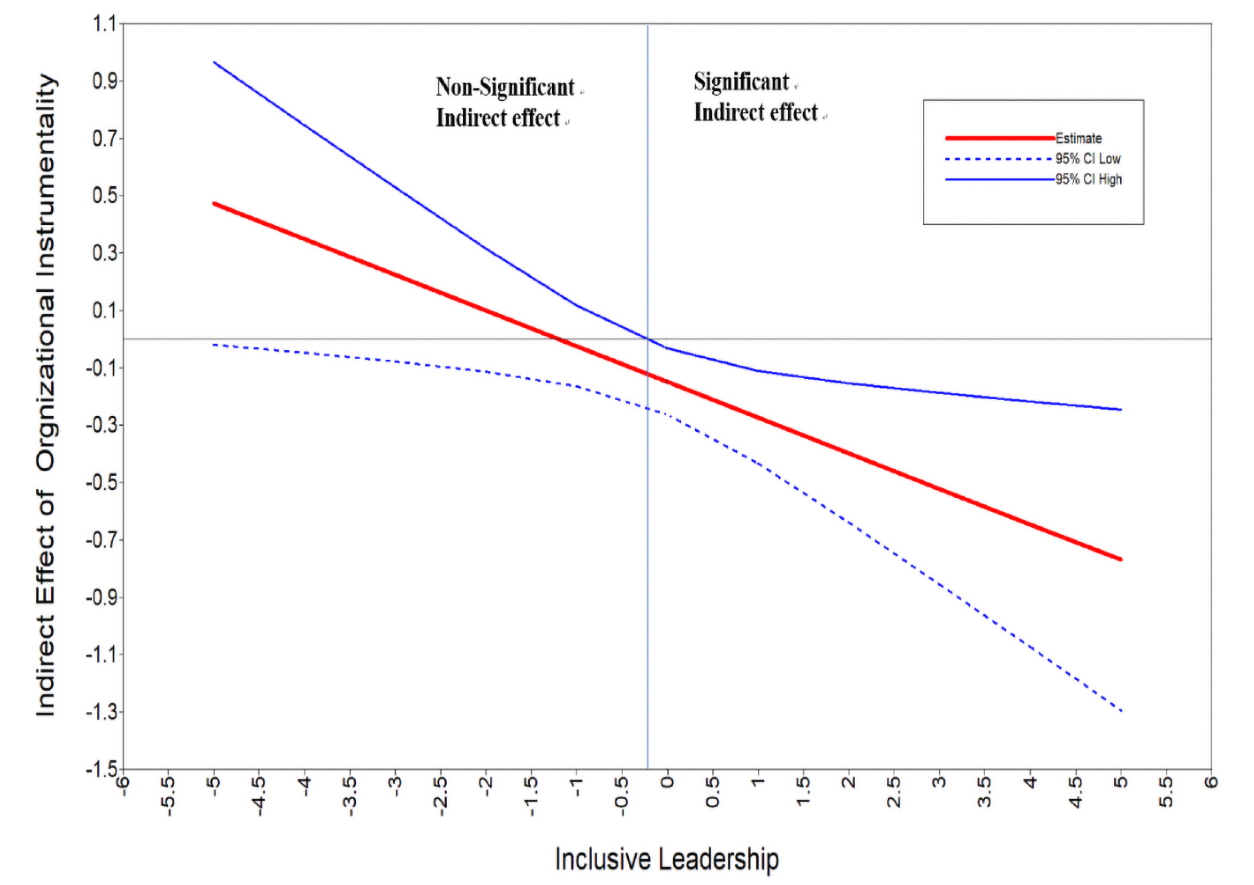
FIGURE 4 | The moderation effect of job crafting on turnover intention through organizational